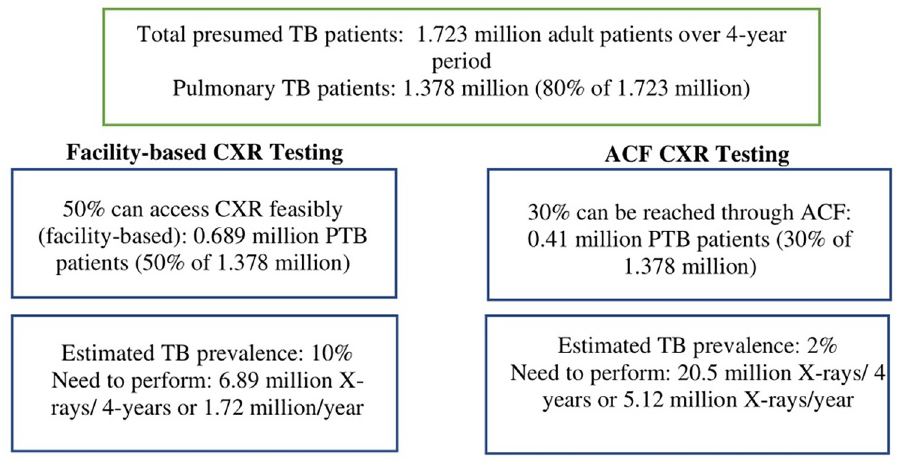
Fig 1. Potentially symptomatic people to be examined with CAD in facility-based and ACF settings to meet Pakistan’s NSP targets (4 years). Active case finding ACF; National Strategic Plan NSP, Computer-aided detection CAD, Pulmonary TBPTB. Facility-based CXR testing is based on the NSP, Pakistan’s assumptions and in addition, we assumed with ACF CXR testing considering the cost with offline deployment of CAD software. The number of presumed TB patients is cumulative for 4